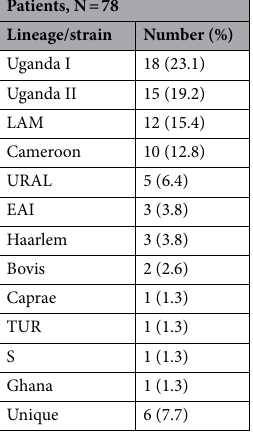
Table 3. Distribution of MTB